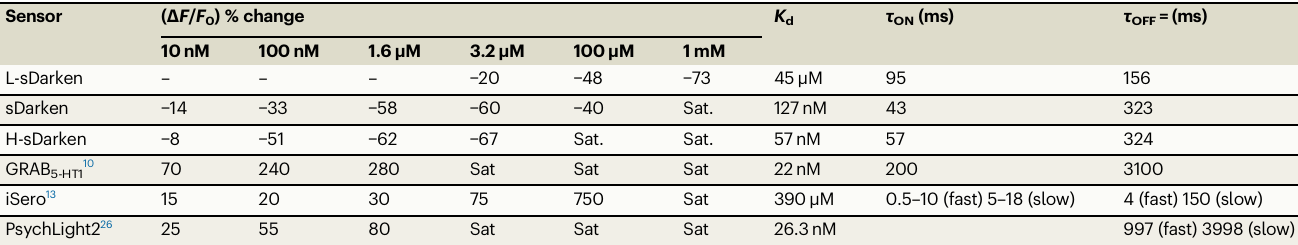
Table 1 | Comparison of genetically encoded serotonin sensors